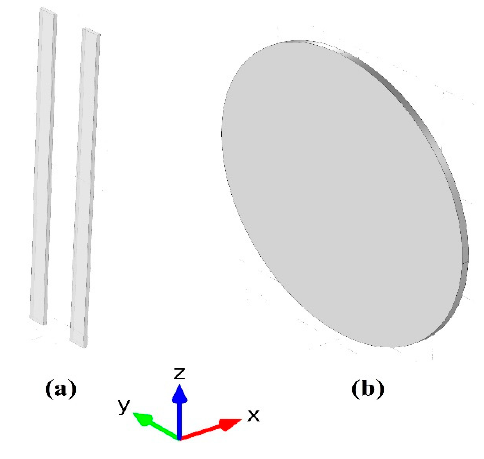
Figure 1. Used collector designs ( a ) 2 bars, and ( b ) traditional straight metal sheet.